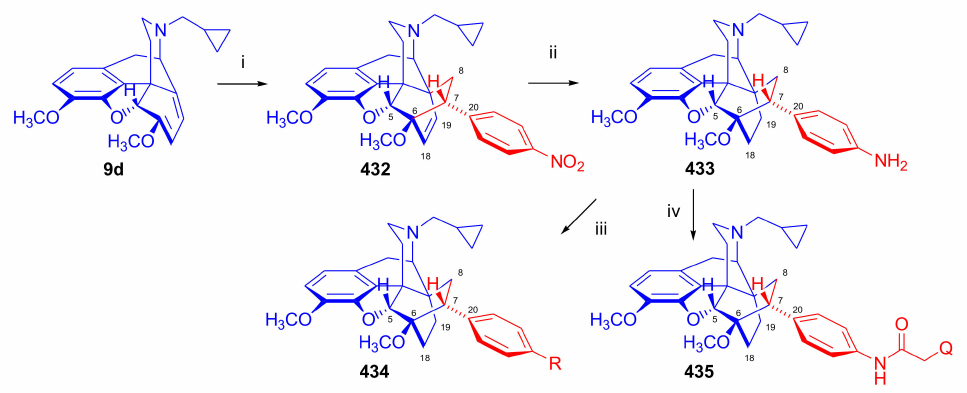
Figure 108. Synthesis of 7 α -phenyl-6,14-ethenomorphinan derivatives. Reagents and conditions : (i): 4-nitrostyrene, xylene, reflux, 24 h, 78%; (ii): H 2 , Pd-C, 4.4 bar, 50 ◦ C, 36 h, 84%; (iii): (A) RX, NaCO 3 , DMF, 30 ◦ C, 4 h or (B) dibromoalkanes, Na 2 CO 3 , acetonitrile, 110 ◦ C, microwave, or C : RX/RCOCl, Et 3 N, CH 2 Cl 2 , 70 ◦ C, 2 h; and (iv): various acids, DIPEA, HATU, CH 2 Cl 2 , room temperature, 2 h. The 7 α -(4-aminophenyl) derivative ( 422c , p NH 2 , SLL-004C, Figure 106) was